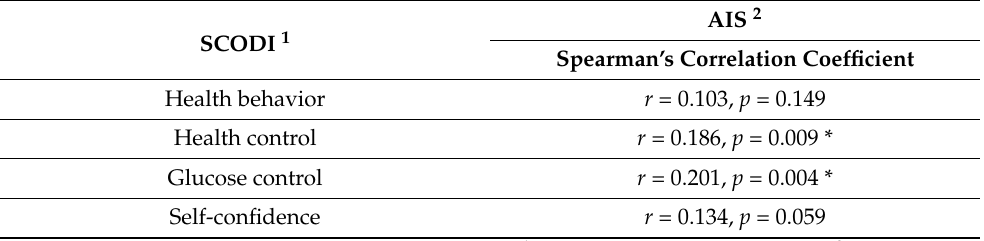
Table 4. Disease acceptance and the level of self-care.